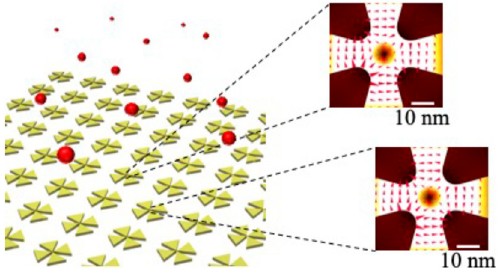
Figure 1: Schematic of the proposed light – matter interaction platform with an array of the plasmonic nanosystem where each tetramer unit exhibits a quadrupolar oscillating field due to collective oscillations of plasmonic